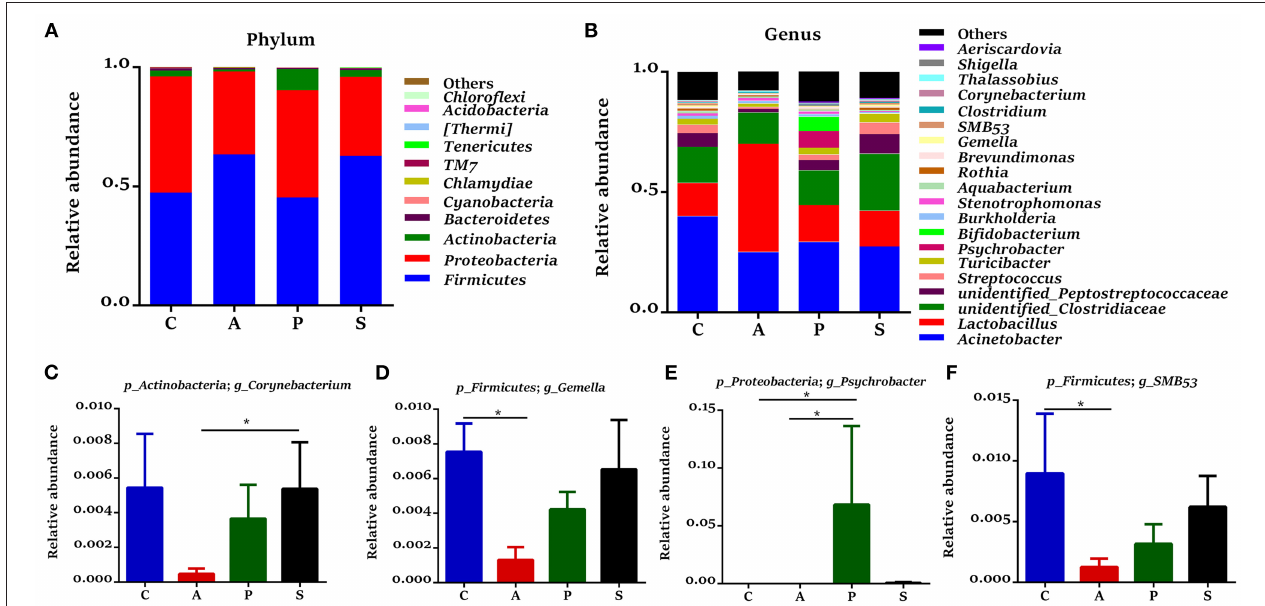
FIGURE 7 | Gut microbiota community composition in the ileum of offspring piglets. Abundances of the ileal microbiota at (A) phylum and (B) genus levels of offspring piglets. All phyla and the top 20 genera were listed. Comparison of relative abundances at (C–F) genus level was analyzed by the Kruskal-Wallis rank-sum test.